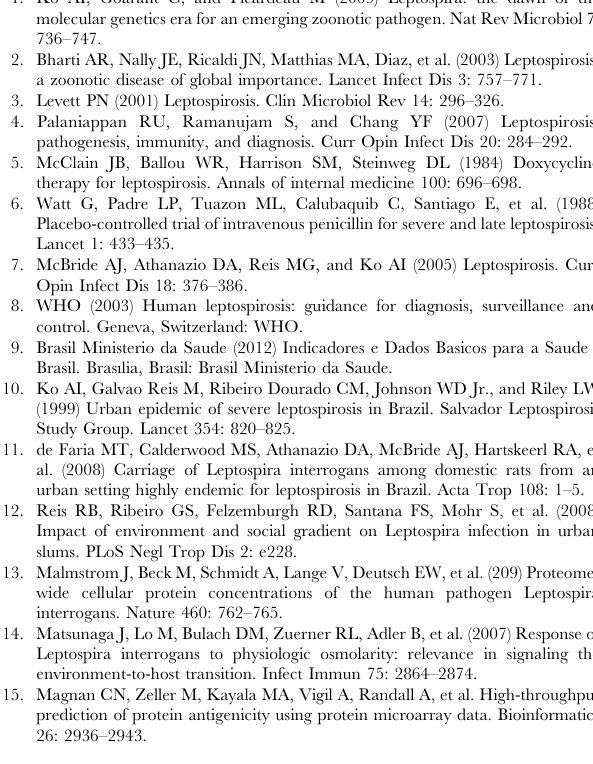
Table S2 Clinical characteristics of the leptospirosis patients providing sera for the protein microarray evaluation. Table S3 List of seroreactive antigens. Table S4 Reactivity signals of patients’ acute serum against the antigens LipL32, LigA Repeats7–13, LigB Repeats7–12 in the protein microarray according to patient characteristics. Table S5 Accuracy of the differentially reactive antigens after immunostrips